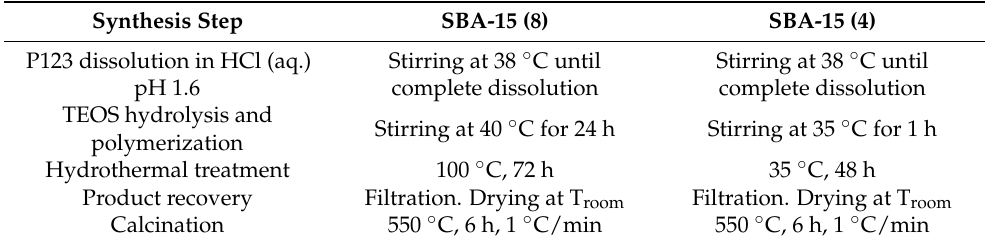
Table 1. Synthetic procedures of SBA-15